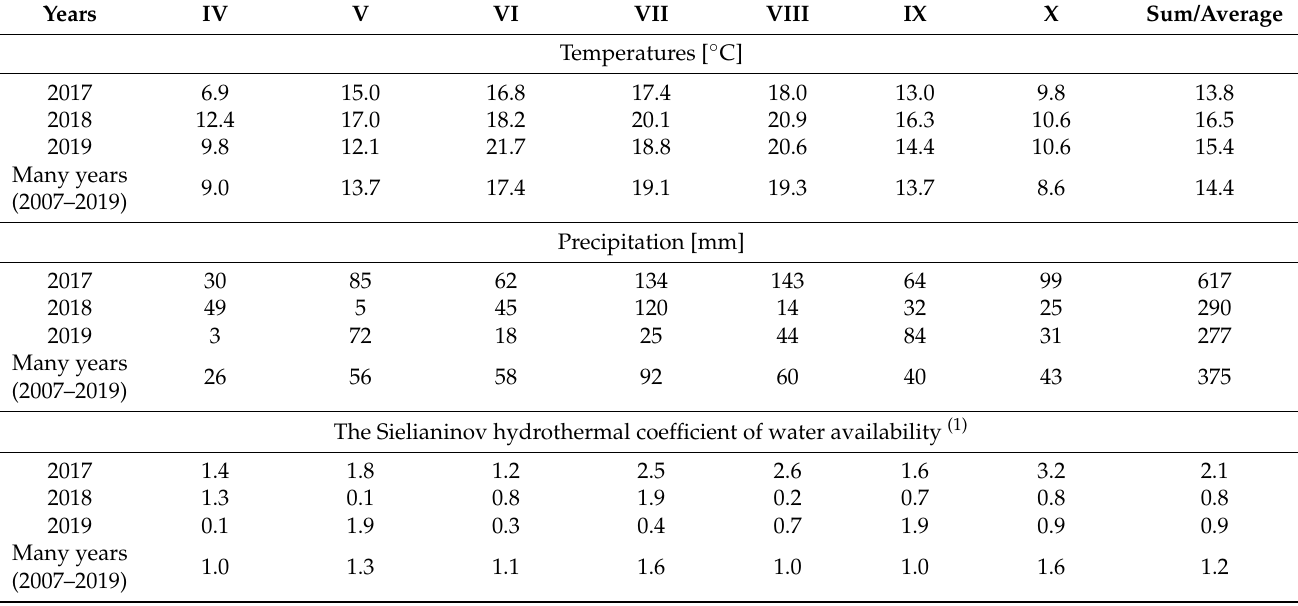
Table 5. Average monthly air temperatures and monthly total precipitation in individual growing